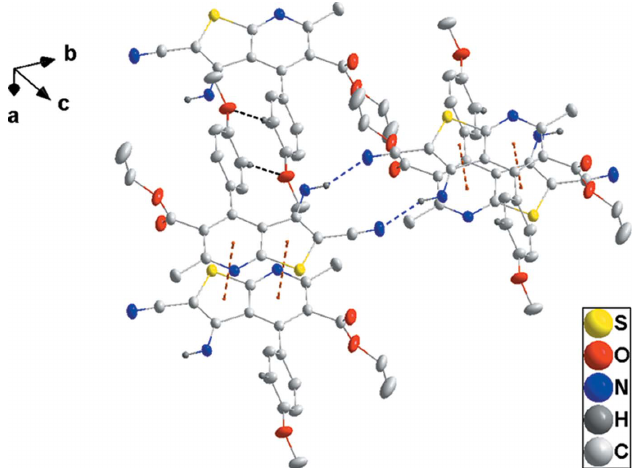
Figure 3 Oblique view of the intermolecular interactions. C—H (cid:2)(cid:2)(cid:2) O and N— H (cid:2)(cid:2)(cid:2) N hydrogen bonds are shown, respectively, as black and blue dashed lines while the (cid:2) – (cid:2) -stacking interactions are shown as orange dashed lines.